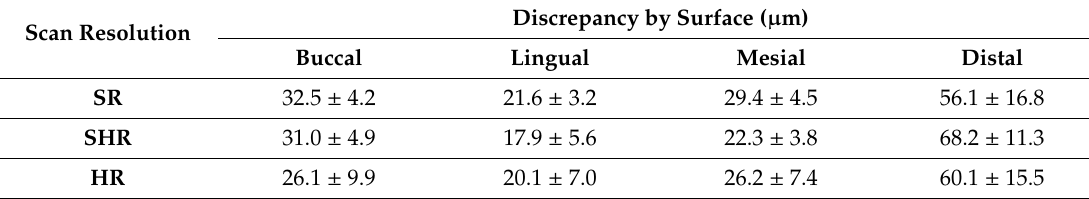
Figure 5. Mean discrepancy ( μ m) along the preparation finish line by tooth surface. Horizontal bars indicate significant differences ( p < 0.05). Shared lowercase letters indicate no significant difference in discrepancy between tooth surfaces within groups. Distal surfaces showed significantly higher discrepancies when compared to other tooth surfaces across all three groups. Table 3. Mean discrepancy by tooth surface ( μ m).